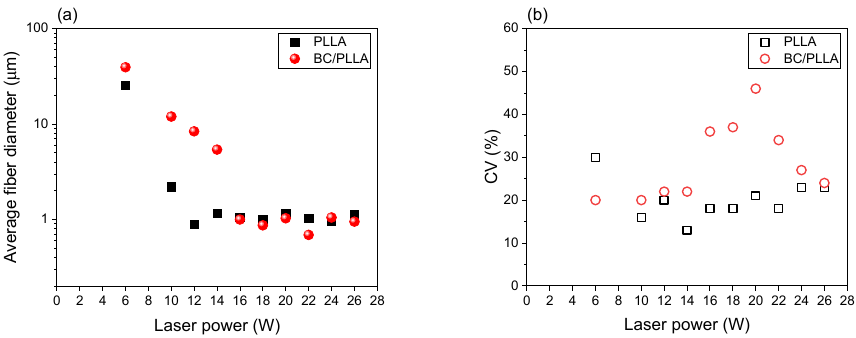
Figure 8. ( a ) Variations in the average fiber diameter and ( b ) coefficient of variation (CV) with laser power for the electrospun PLLA and BC/PLLA webs.